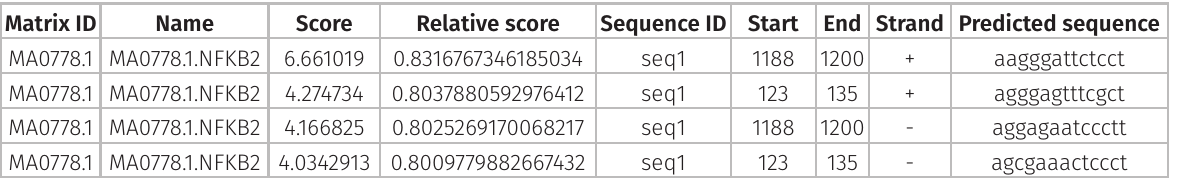
Table III. Binding of NFKB2 on miR-518a-5p promoter.